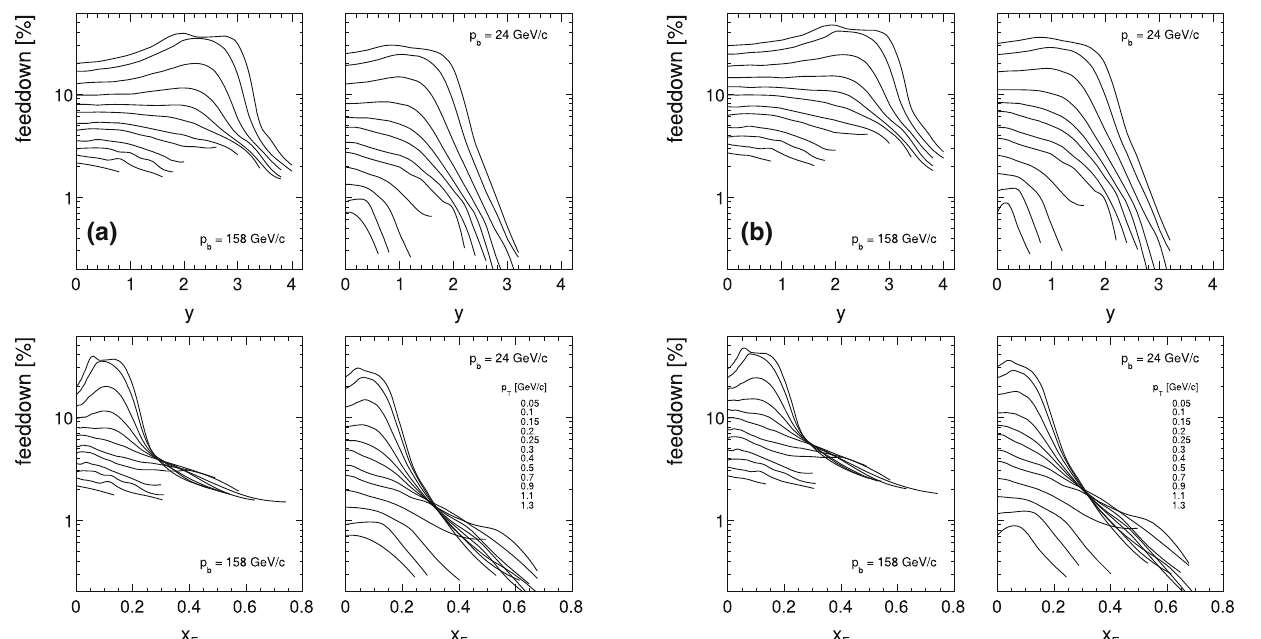
, Λ and Σ − b (K 0 + K 0 ), Λ and Σ − as a function of y and x F for beam momenta of 158 and S S L